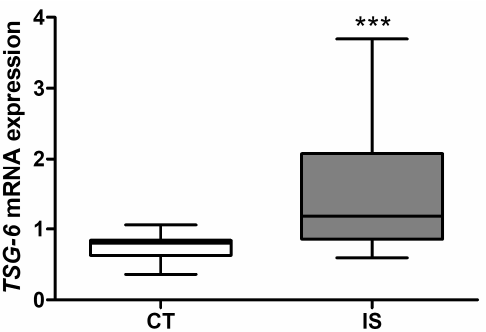
Figure 3. TSG-6 mRNA expression is elevated 48 h after ischemic stroke in PBMC from patients. TSG-6 mRNA levels in peripheral blood mononuclear cells (PBMCs) isolated from blood of healthy subjects (CT; n = 13) or patients subjected to ischemic stroke 48 h before (IS; n = 25). Data are shown as median, interquartile range and minimum and maximum values; *** p < 0.01 vs. CT (Mann–Whitney test).